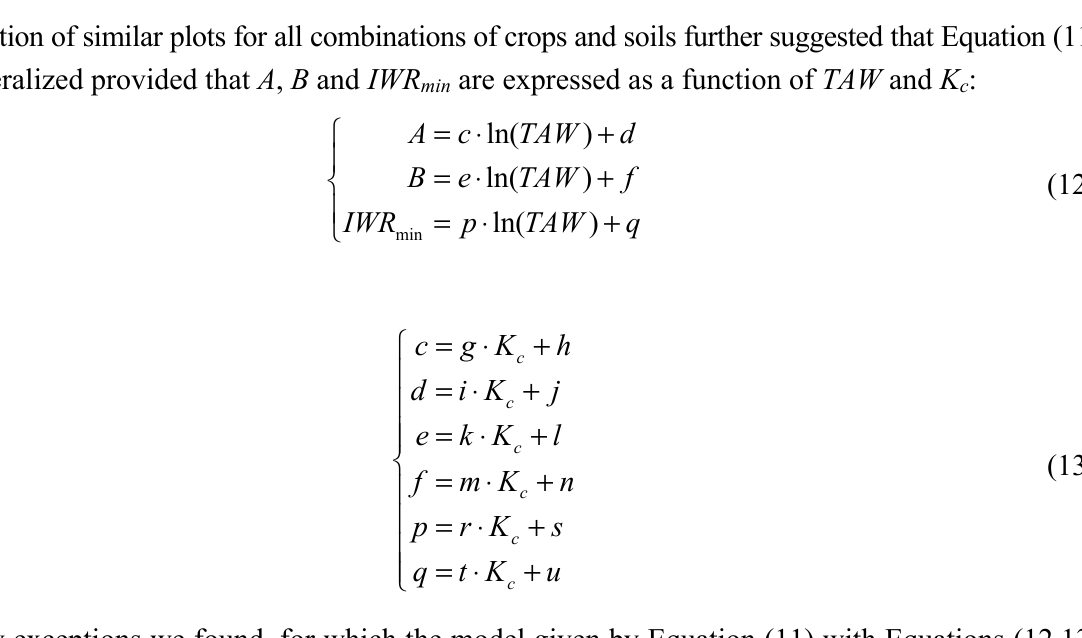
and  P − ET . The plot is based on  200 0 200 . A similar relationship was found for all other min